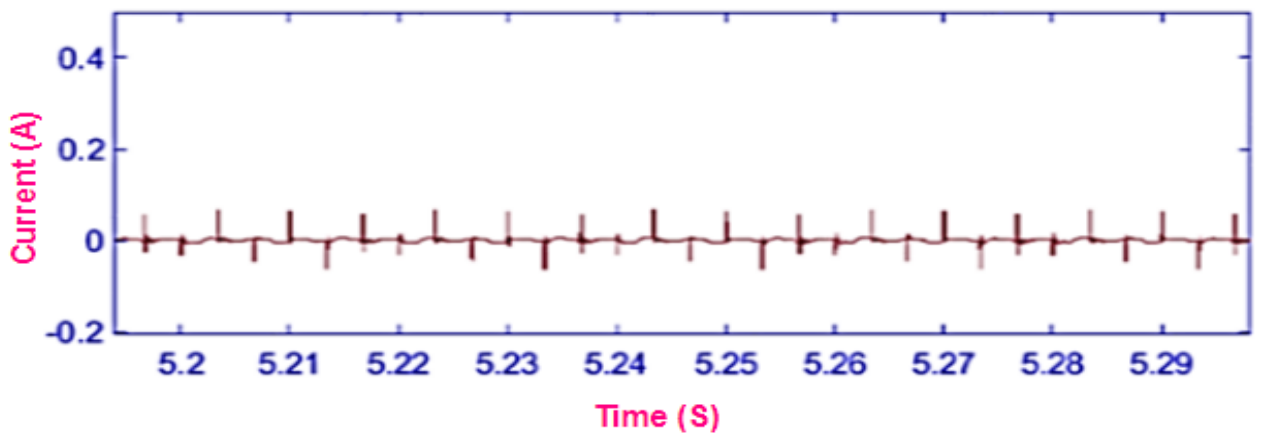
Figure 26. CBC of modified ANN-based sensorless induction motor with cascaded H-bridge inverter.